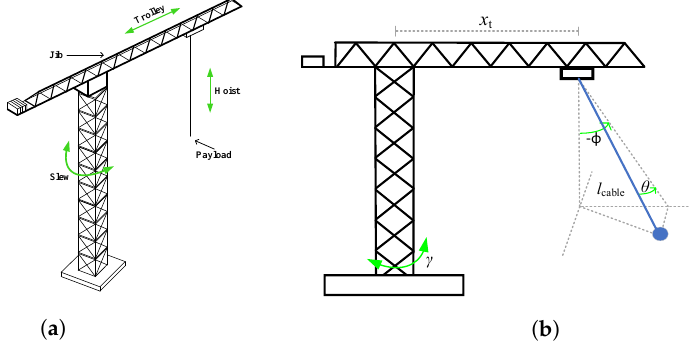
Figure 1. ( a ) Tower crane with three degrees of freedom: rotational movement (slew), horizontal movement (trolley), and vertical movement (hoist). ( b ) Simplified free body diagram of the dynamics.